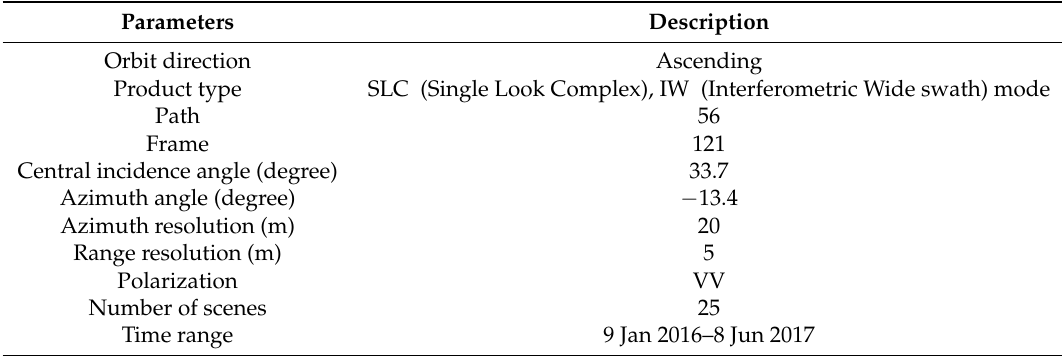
Table 1. Parameters of the Sentinel-1A